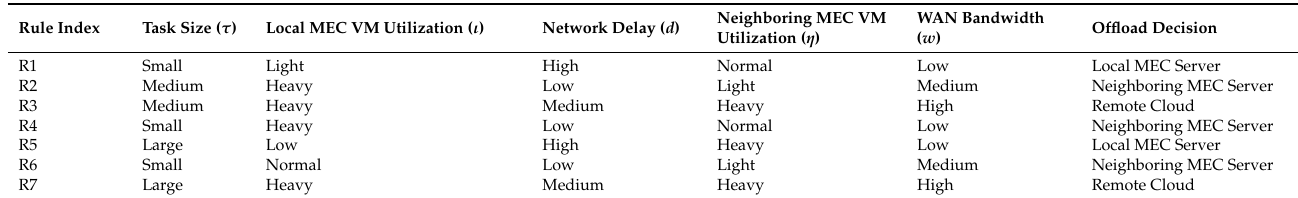
Table 3. Example fuzzy